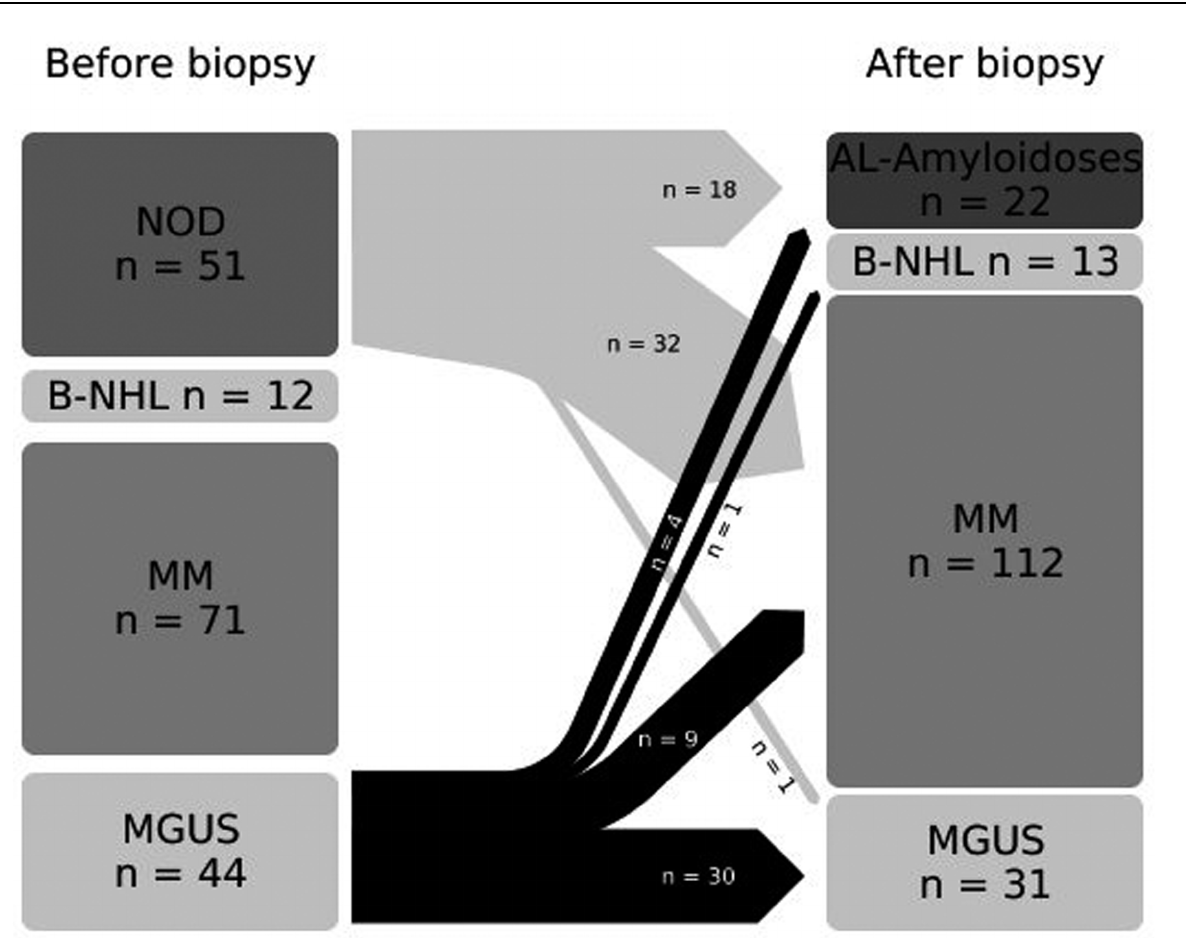
Figure 3. Shift in clinical diagnosis as an effect of the results of the kidney biopsies. Abbrevia- tions: B-NHL, B-cell non-Hodgkin lymphoma; MGUS, monoclonal gammopathy of undetermined significance; and MM, multiple myeloma.